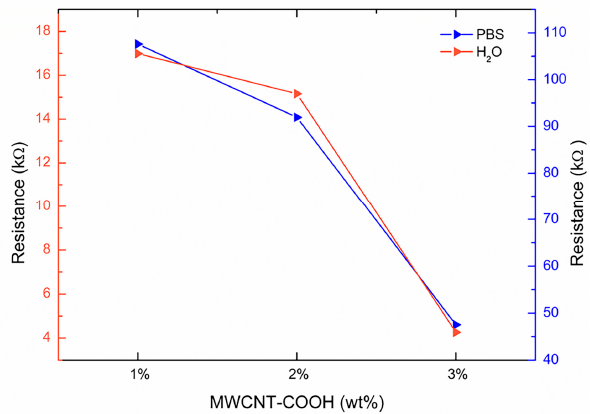
Figure 12. Electrical resistance of PNIPAM/MWCNT-COOH composite hydrogels hydrated in pure water (right axis) and in PBS solution (left axis) as a function of filler concentration. Resistance values corresponding to R 2 values determined from fitting of impedance data.